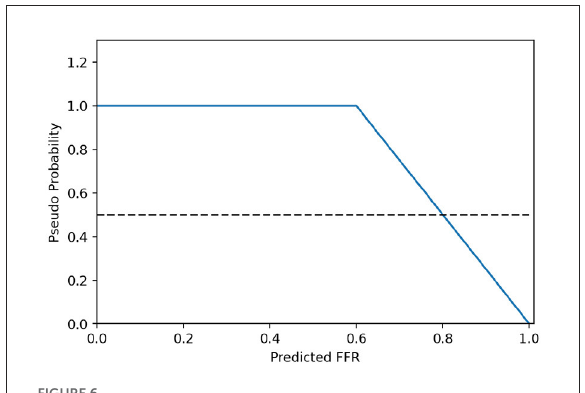
FIGURE6 Transformation from predicted FFR values to pseudo probabilities.